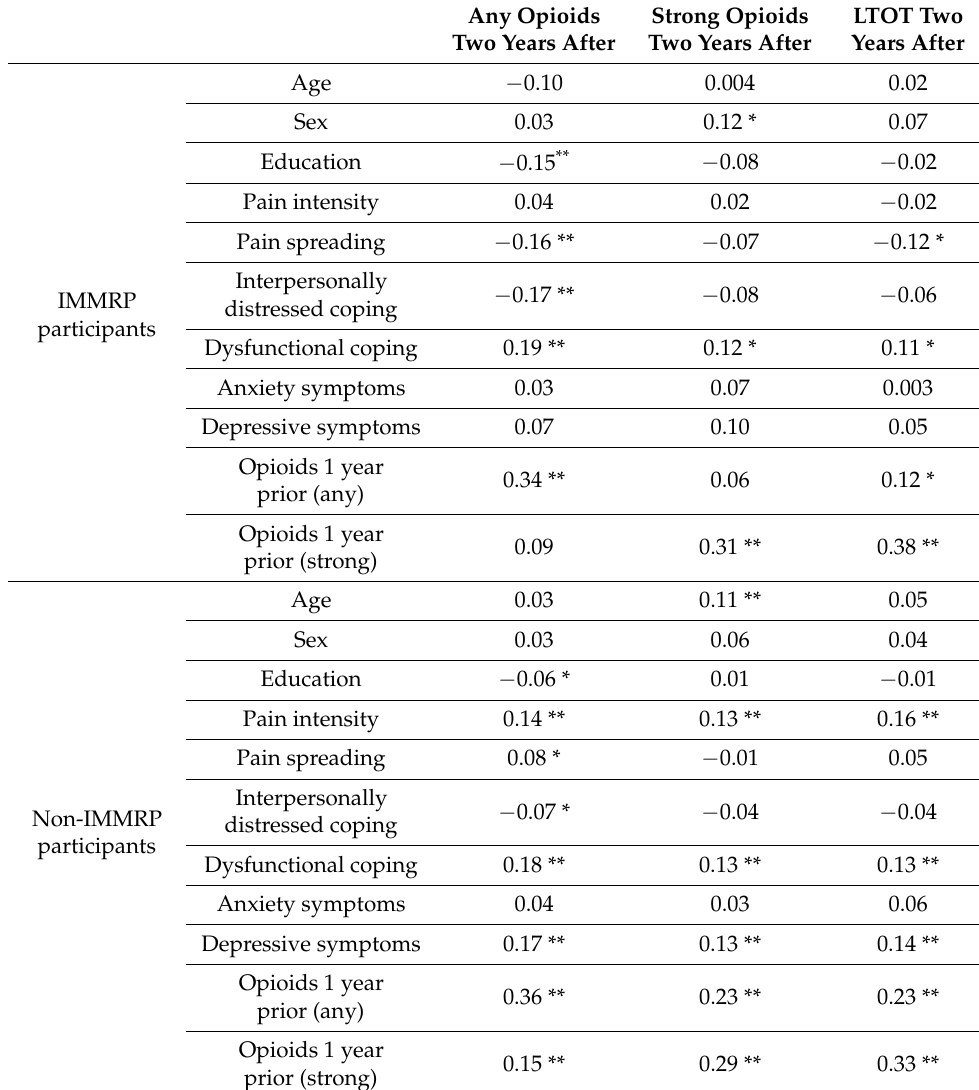
Table 3. Univariate associations between baseline predictors and opioid outcomes for the sample who did, and did not, receive IMMRP after multidisciplinary